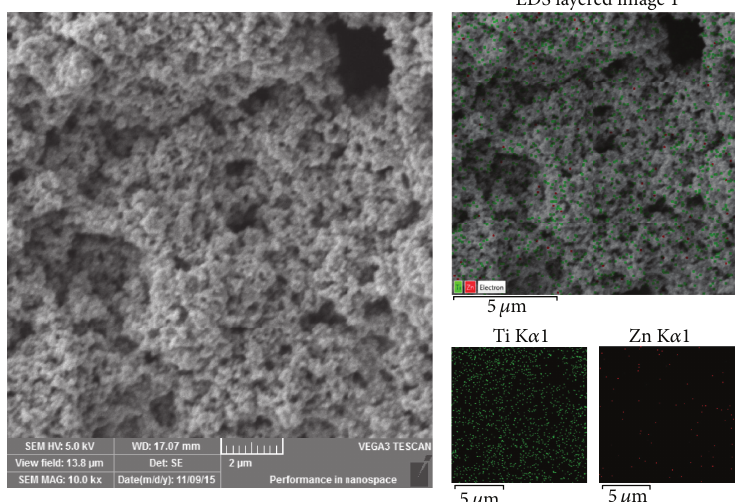
Figure 3: SEM image and overlaid EDS data of resulting hybrid ZnO/TiO 2 nanopowder with corresponding identification of Zn and Ti.